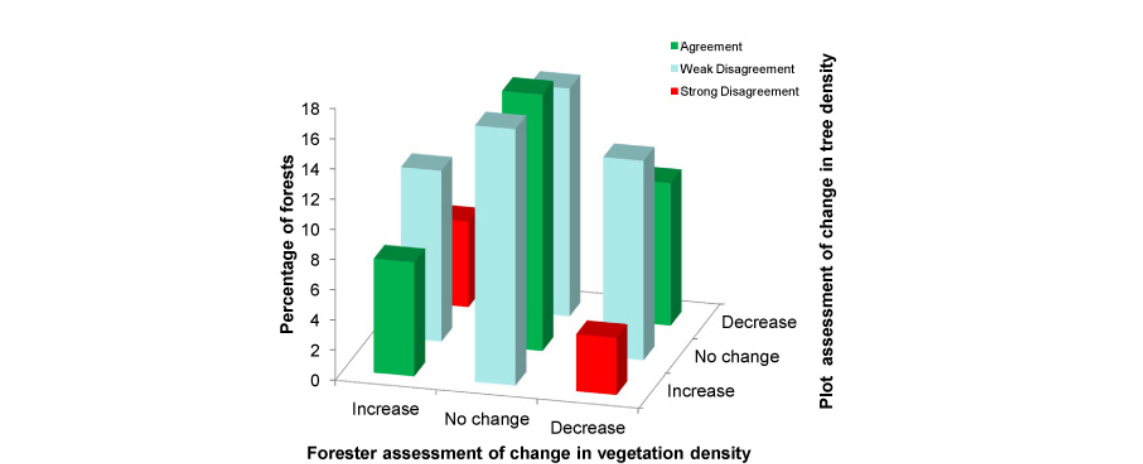
Fig. 3. Plot-based assessment of change in tree density vs. forester assessment of change in vegetation